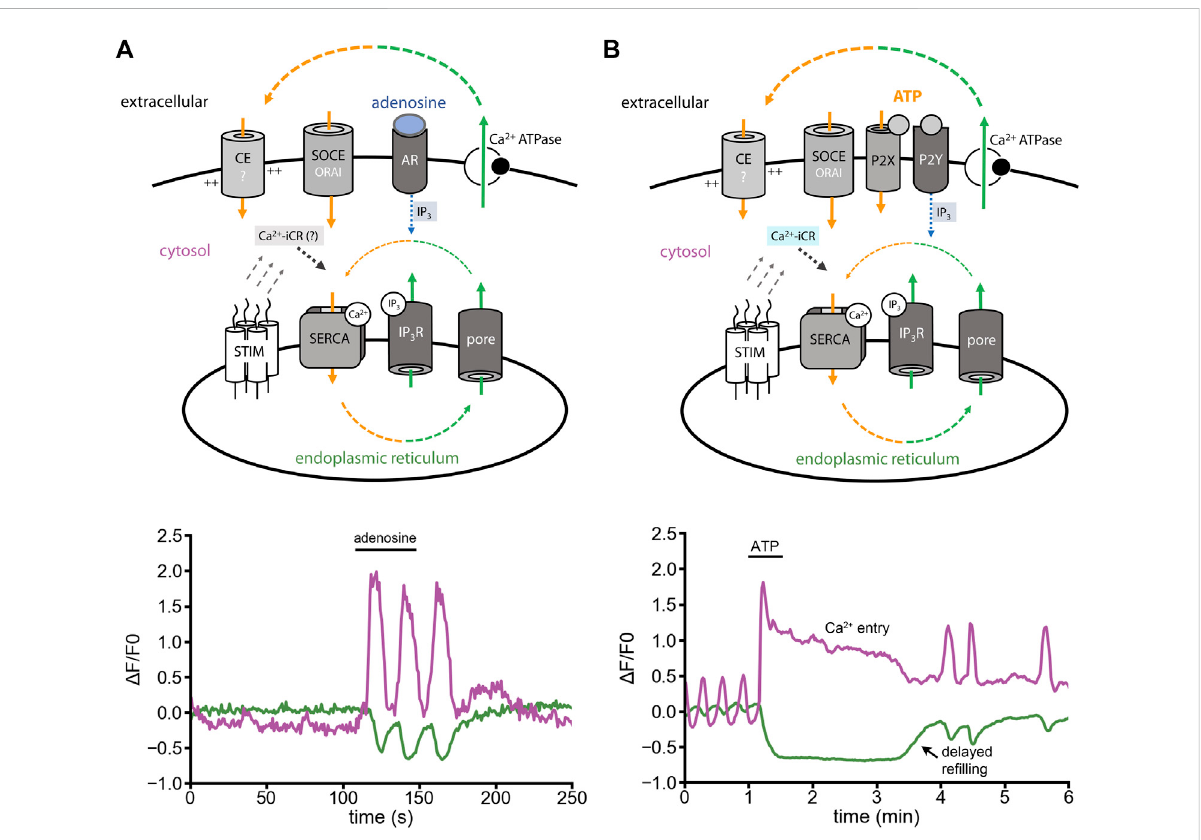
FIGURE 3 Adenosine- versus ATP-induced Ca 2+ release in cultured astrocytes. Experiments were performed in presence of extracellular Ca 2+ . (A) Minimal model: Adenosine evokes IP 3 -iCR (IP 3 , blue). Ca 2+ oscillations are induced by IP 3 -iCR. Ca 2+ release and Ca 2+ entry are in balance. Theoretically, Ca 2+ -iCR should contribute to the Ca 2+ fl uxes (indicated in grey). Lower panel: Oscillatory Ca 2+ cycle induced by adenosine (10 µM) with cytosolic Ca 2+ signals (magenta) and ER Ca 2+ signals (green). (B) Minimal model: ATP binds to P2X and P2Y receptors. Metabotropic P2Y receptors evoke IP 3 -iCR (blue). P2X receptors might promote depolarizing Ca 2+ in fl ux, activation of voltage-gated Ca 2+ channels and ER Ca 2+ release through Ca 2+ -iCR (cyan). Lower panel: In response to ATP, the cytosolic Ca 2+ increases while the ER Ca 2+ decreases. Ca 2+ entry is induced and creates a signal shoulder in the cytosol. The ER is not re fi lled during the Ca 2+ entry shoulder. [Modi fi ed according to (Schulte et al.,